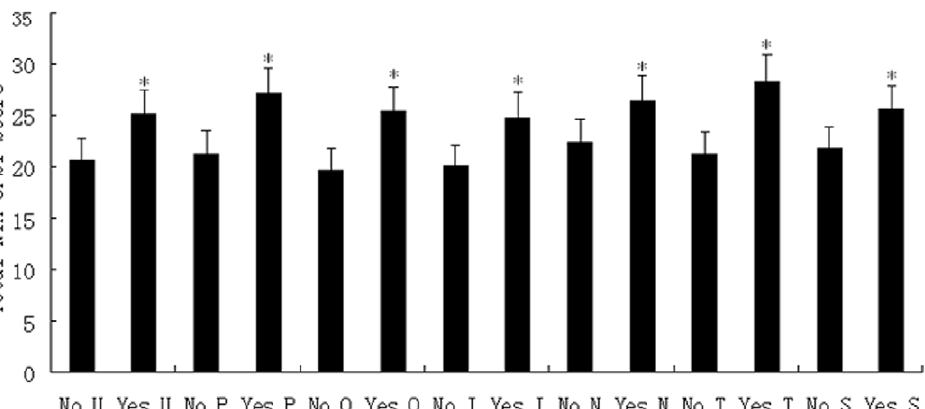
Figure 2. Comparison of NIH-CPSI symptom scores between patients with and without each UPOINTS domain. Mean total NIH-CPSI symptom scores were compared between patients with and without each urinary (U), psychosocial (P), organ specific (O), infection (I), neurological/ systemic (N), tenderness (T), and sexual dysfunction (S) UPOINTS domain, respectively. Significant difference was seen in each domain between no and yes (*P , 0.05).